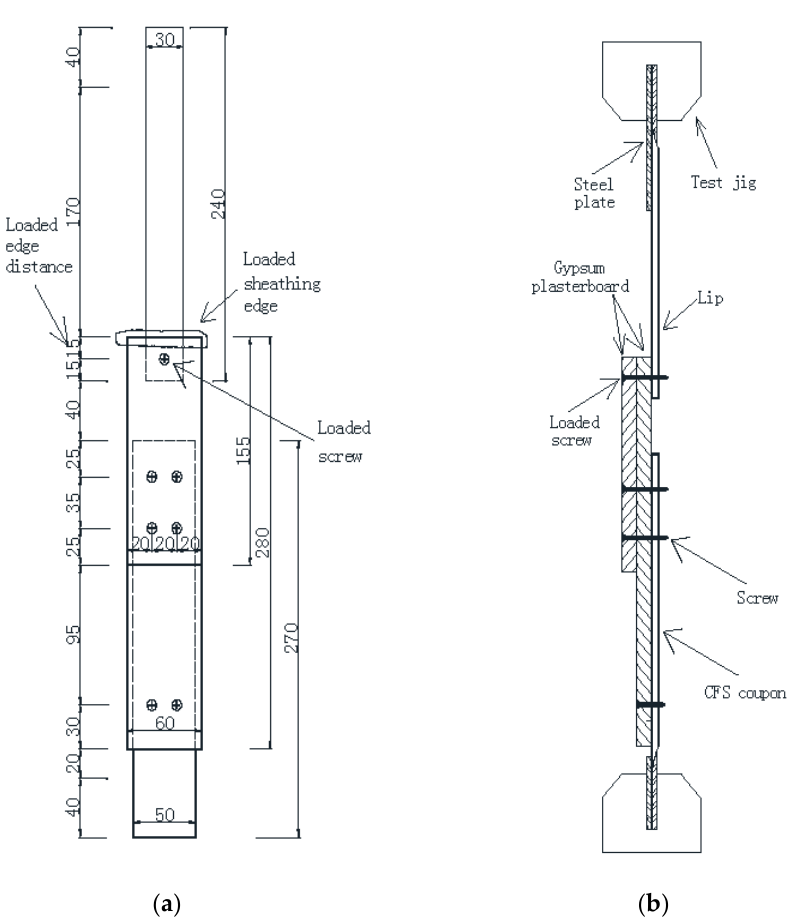
Figure 2. Connection details with double ‐ layer sheathing and a loaded edge distance of 15 mm: ( a ) front view; and ( b ) side view.